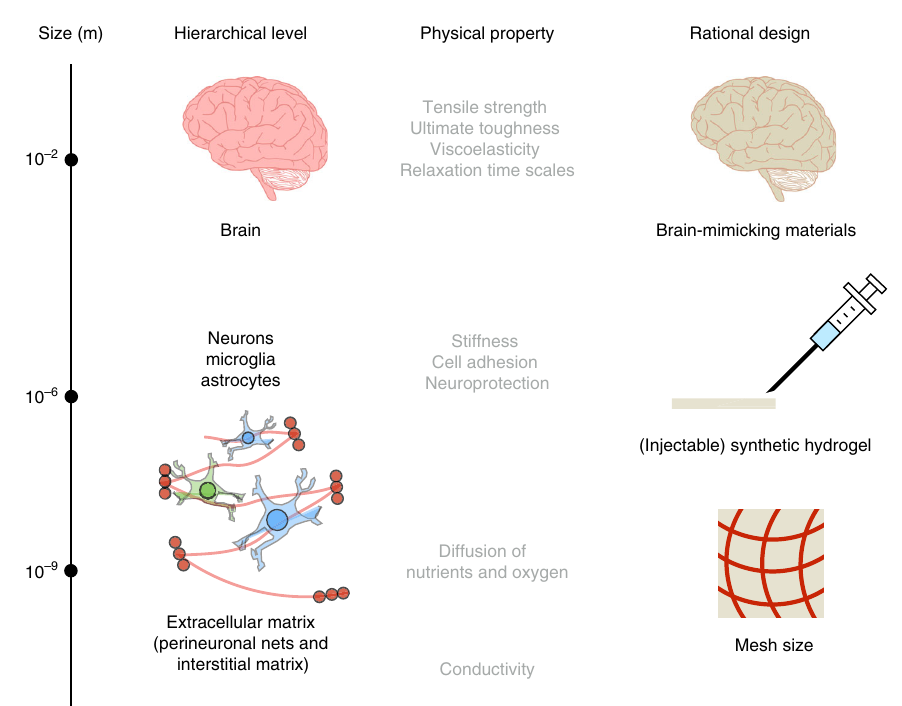
Fig. 1 Physical features of brain tissue that need to be resembled at different scales. The extracellular matrix of the brain (perinueonal net and the neural interstitial matrix) and its protein nanoscale building blocks give brain tissue its physical properties that differ from region to region. Resembling at different scales mechanical properties such as the tensile strength, ultimate toughness, viscoelasticity, relaxation times, stiffness, cell adhesion, and well as other physical features such diffusion of nutrients and oxygen and conductivity are key for the rational design of brain tissue mimicking hydrogels. Biomaterials comprehensively capturing the diverse properties of brain tissue can propel applications such as neural probes for brain – machine interfaces, brain organoids for studying neurogenesis or drug screening and injectable materials to substitute current hard materials to treat certain types of brain tumors such as glioblastoma multiforme. Brain graphic adapted from the following, under a CC BY 3.0 licence: